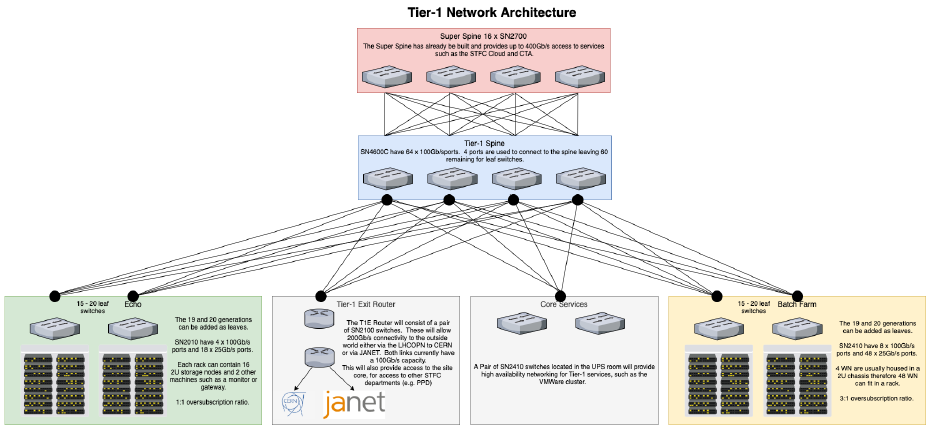
Figure 3. Figuring showing the design of the RAL Tier-1